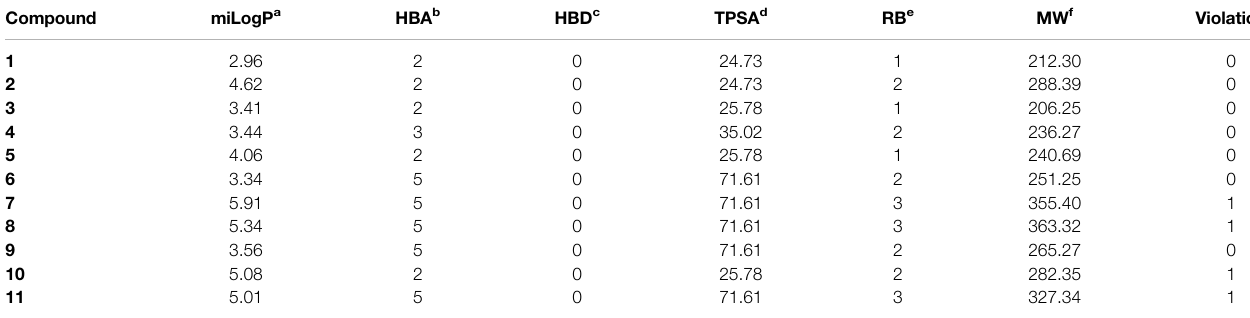
TABLE 5 | Validation † of drug-likeness of the benzopyrazines ( 1 – 11